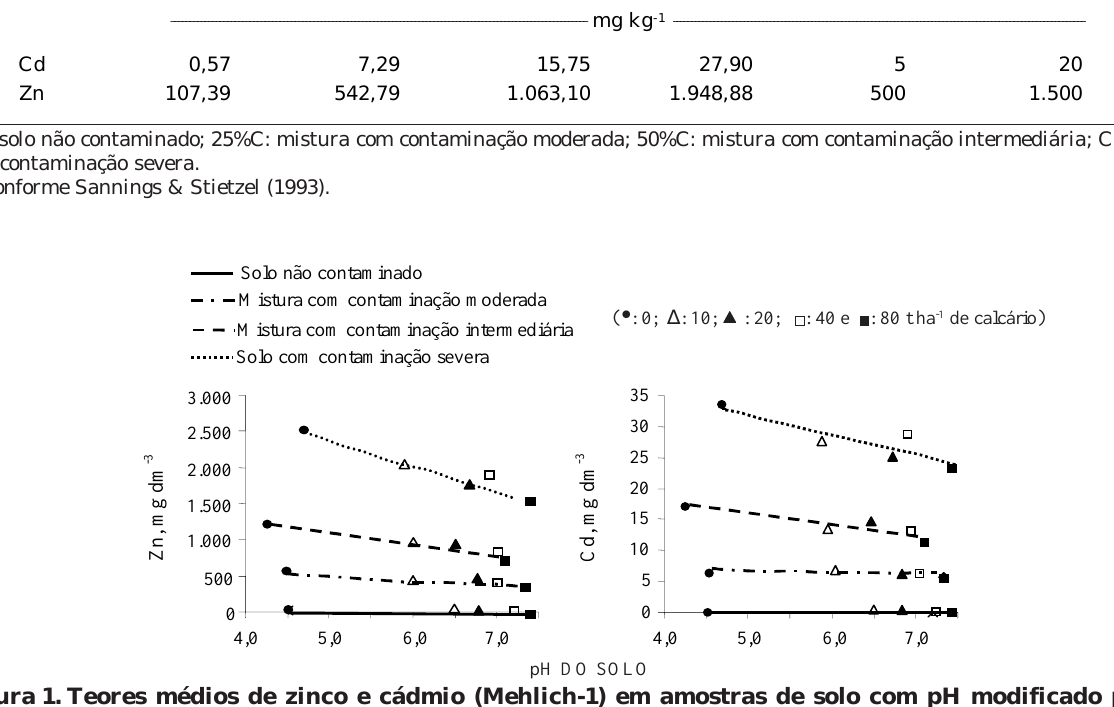
Figura 1. Teores médios de zinco e cádmio (Mehlich-1) em amostras de solo com pH modificado pela adição de calcário e com diferentes níveis de contaminação de zinco e cádmio antes do transplantio das mudas de